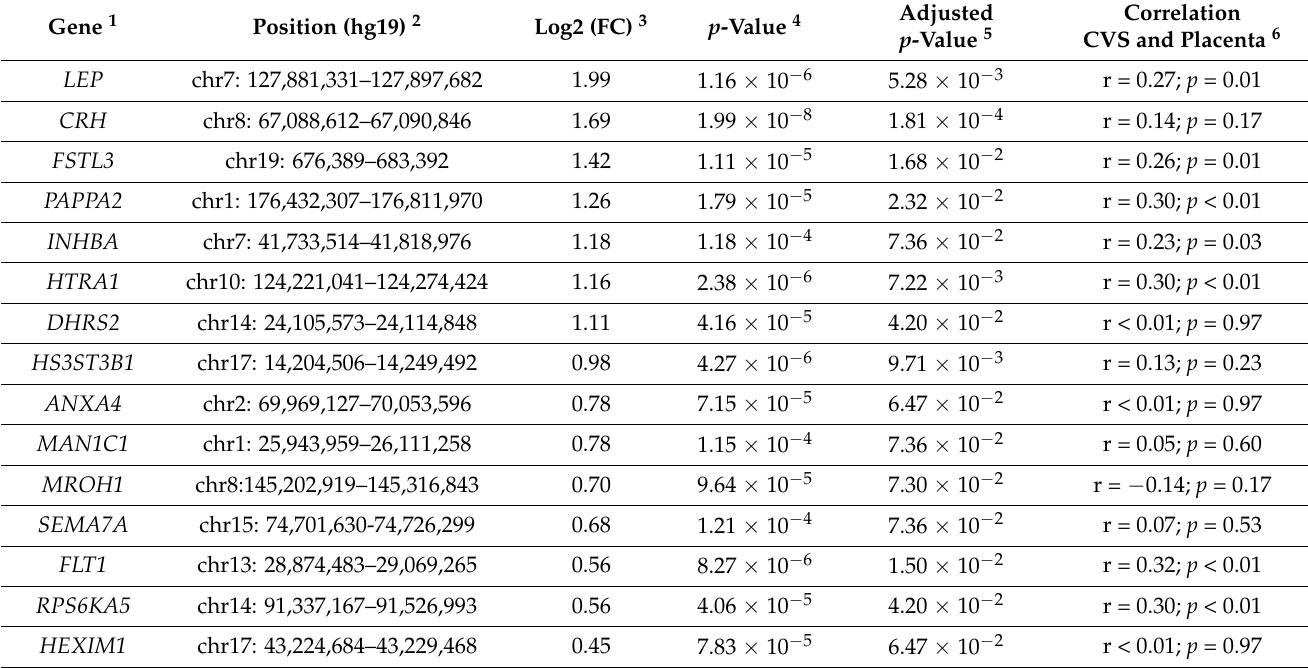
Table 3. Differentially expressed genes in CVS with congenital malformations within the circulatory